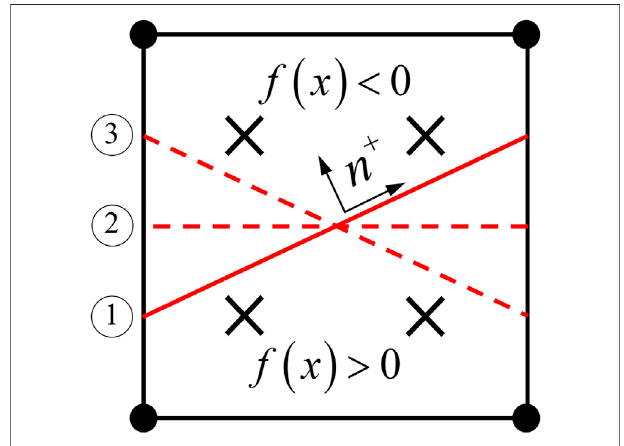
FIGURE4 | Diagram of case where “ smeared integration ” method is not recommended.